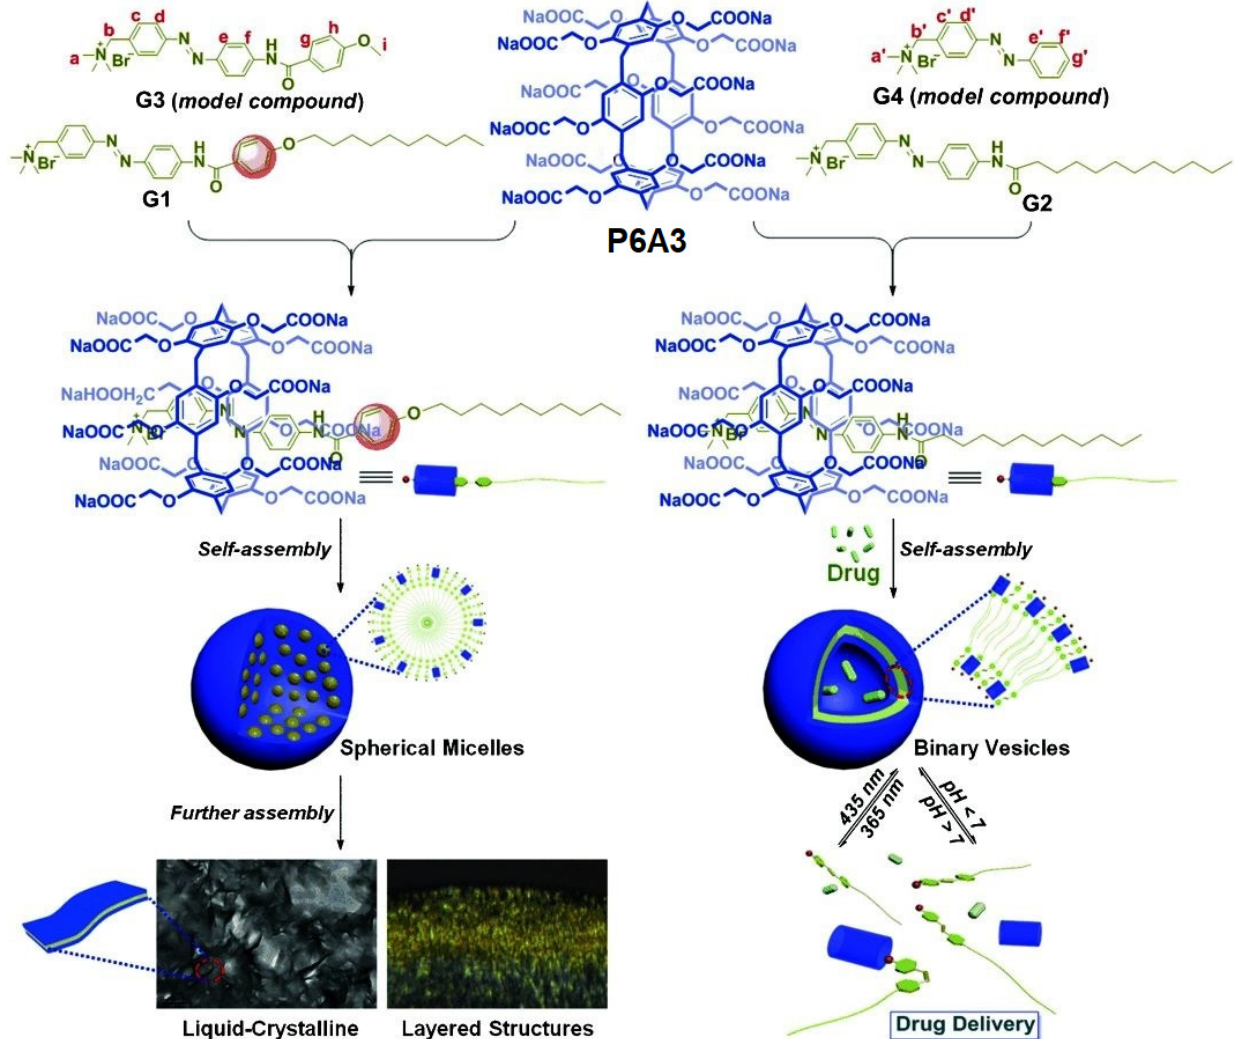
Figure 19. Schematic illustration of the construction of supramolecular micelles “ P6A3 * G1 ” or vesicles “ P6A3 * G2 ” and the application of supramolecular vesicles in drug delivery. Reproduced with the permission of reference [101]. Copyright © Wiley 2015.